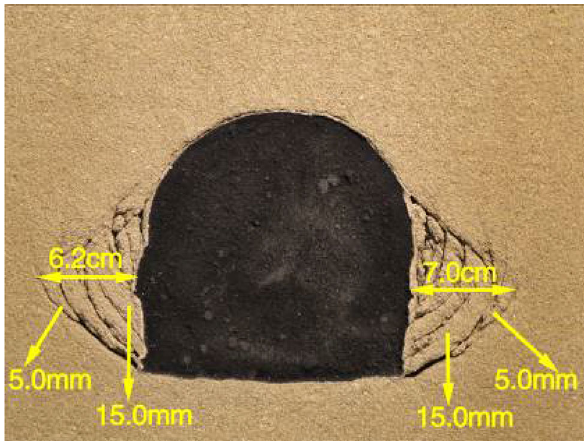
Fig. 10 Width of cracks in the M3